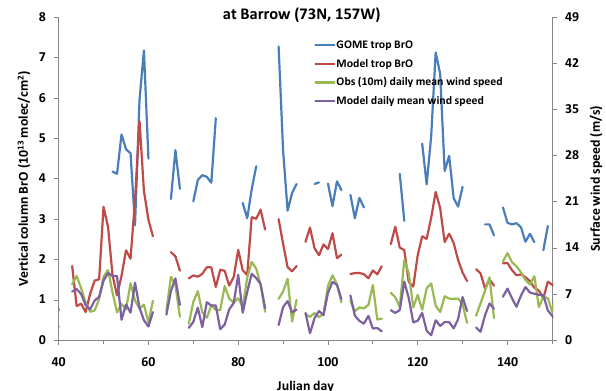
Fig. A1. Observed 10m daily mean wind speeds at Barrow airport (data from National Climatic Data Center) during Julian days 40– 150, 1998, and model daily mean surface wind speeds. Also shown are GOME and model tropospheric column BrO at